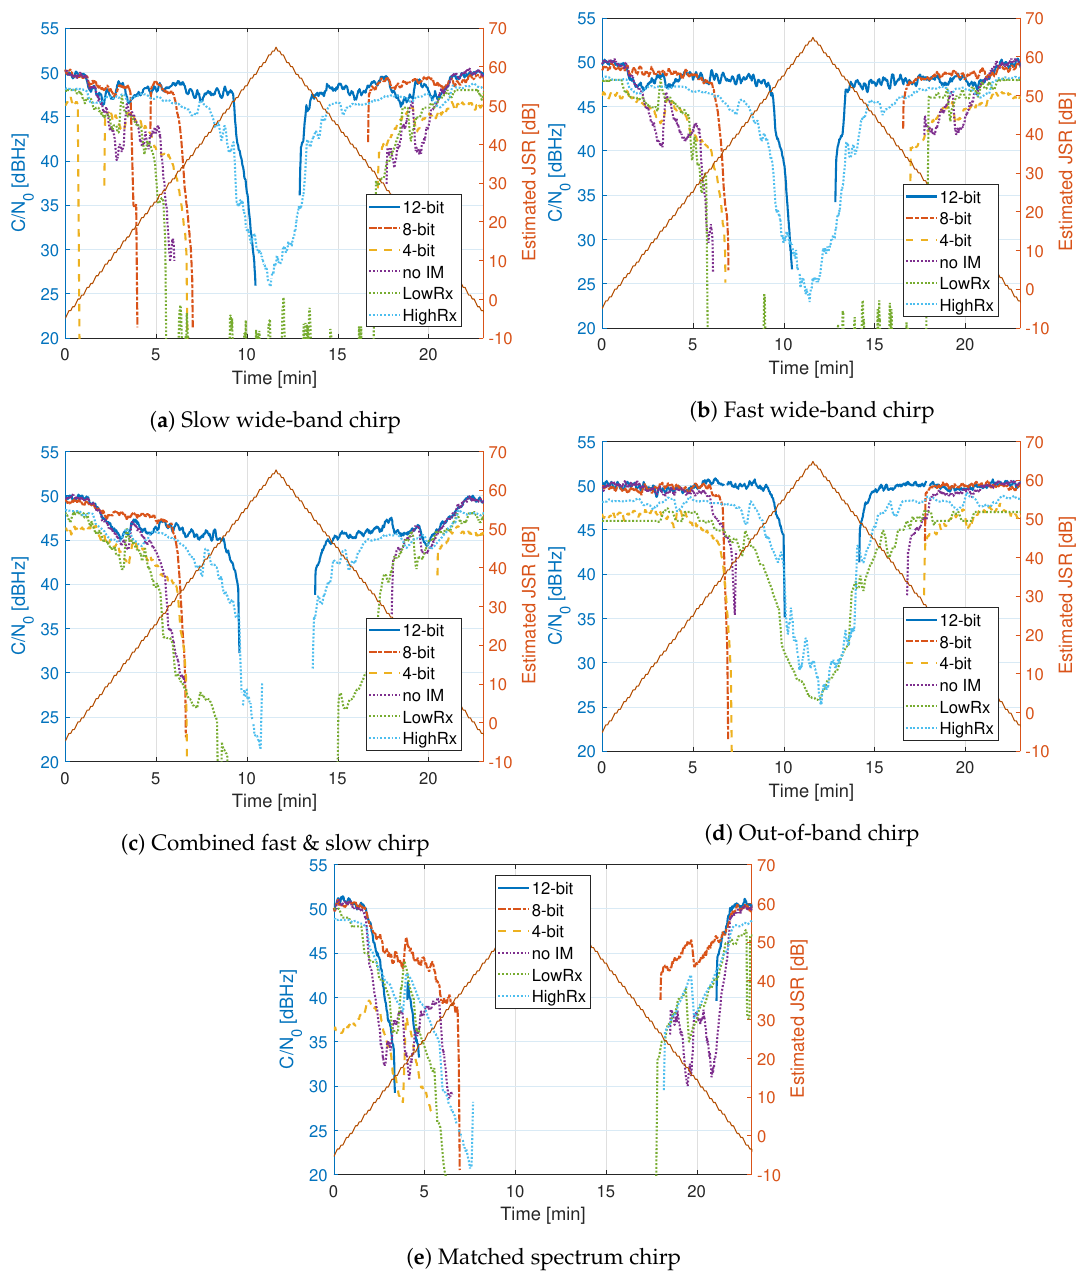
Figure 14. Comparison of tracking outputs for chirp